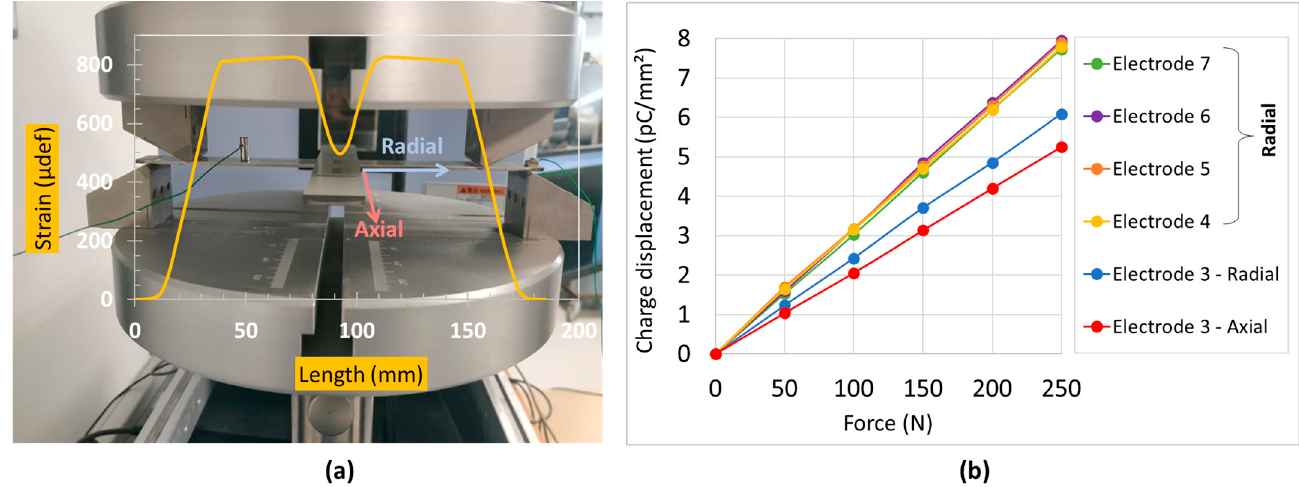
Figure 13. Four-point bending unidirectional test of cross substrate coated with rectangular sensors: ( a ) mechanical strain measured at the central electrode; ( b ) evolution of the charge displacement in response to the mechanical load applied to different electrodes. For the central electrode, the measurement was carried out on both axial and radial directions.